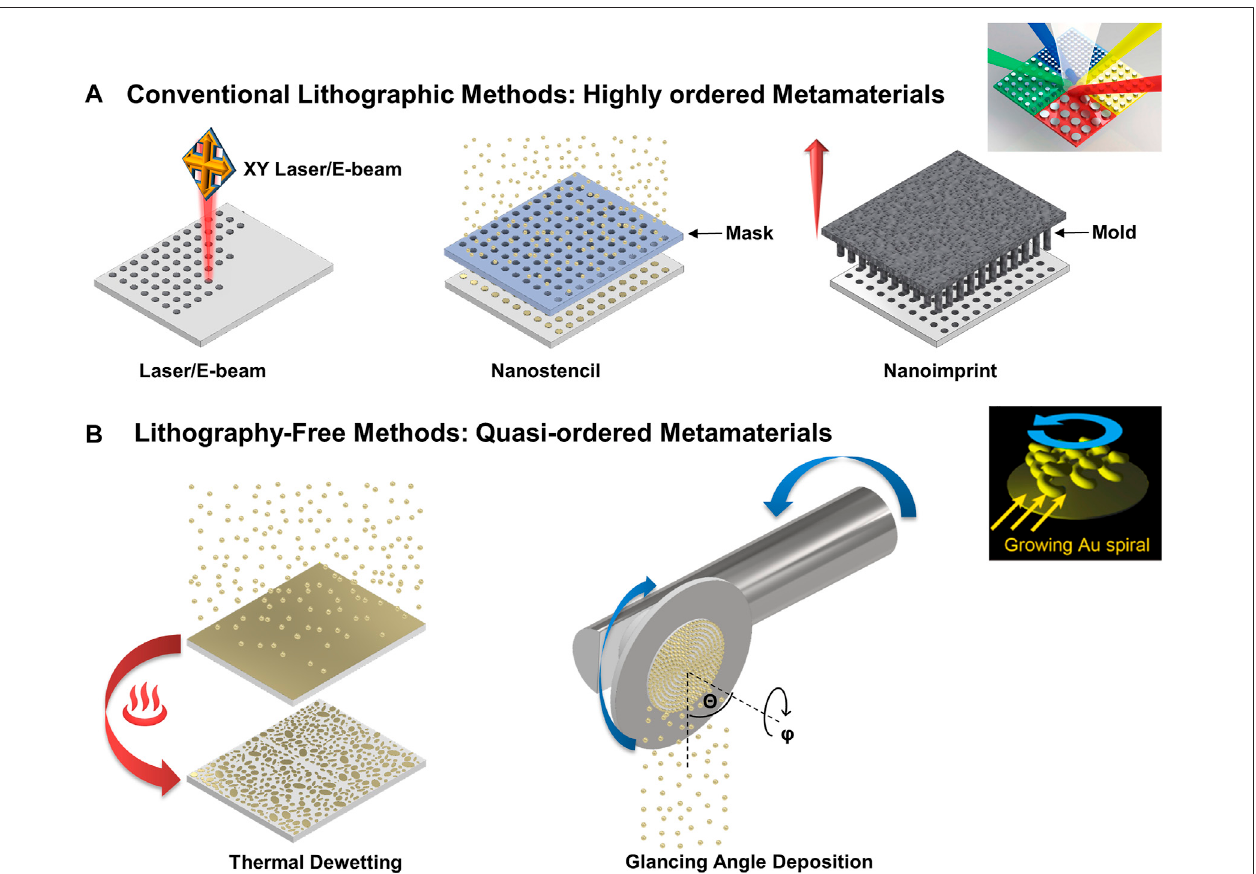
FIGURE 1 | Schematic illustration of conventional lithographic nanofabrication to create highly ordered metamaterials and the lithography-free nanofabrication by nano-patterned/sculptedthin fi lmstodevelopquasi-orderedmetamaterials. (A) Schematicdiagramrepresentingdifferentconventionallithographicmethodsfromleftto right: Laser/E-beam lithography, nanostencil lithography, and nanoimprint lithography. The insert shows an example of a plasmonic color fi lter based on highly ordered plasmonic metamaterials. Adapted and reproduced with permission from Zhao et al. (2017) and Si et al. (2013). Image © MDPI and RSC. (B) Schematic diagram representation of lithography free methods for developing quasi-ordered metamaterials from left to right: Thermal dewetting and glancing angle deposition. The insert shows the chiral plasmonic nanospirals fabrication by glanced angle deposition. Adapted and reproduced with permission from Furusawa and Kan (2020). Image ©